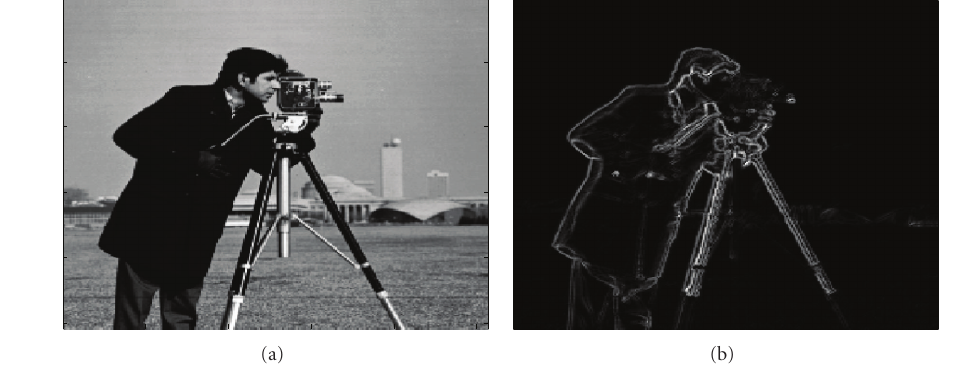
Figure 3: (a) A 2D image and (b) local frequency